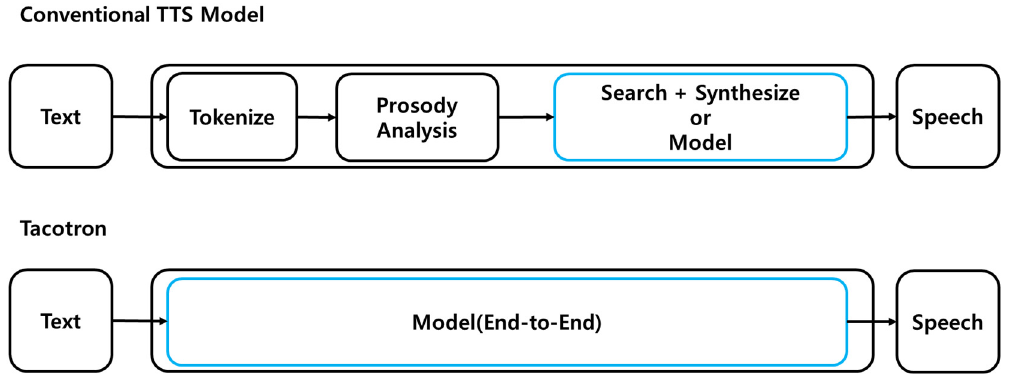
Figure 2. The Tacotron compared to conventional methods.